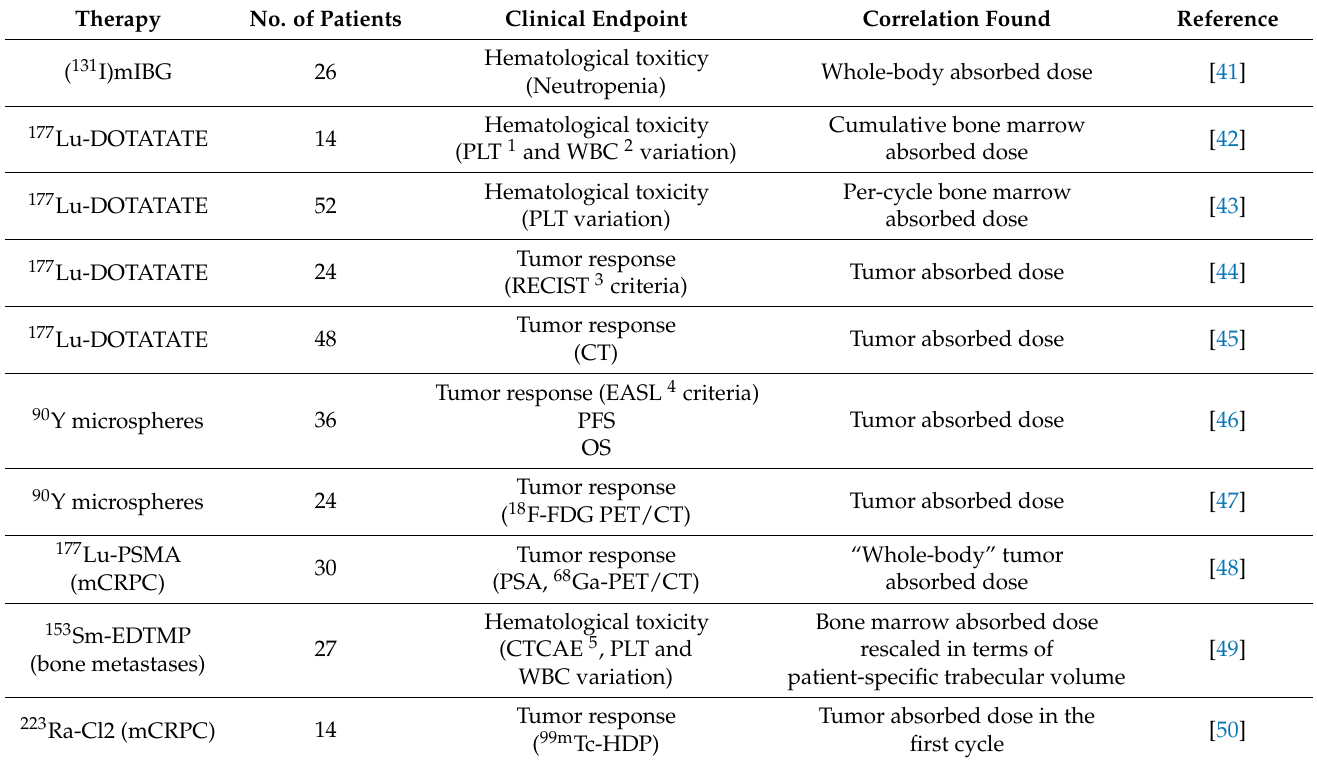
Table 3. Most relevant examples of dose-effect correlations for different TRT cancer treatments reported in the